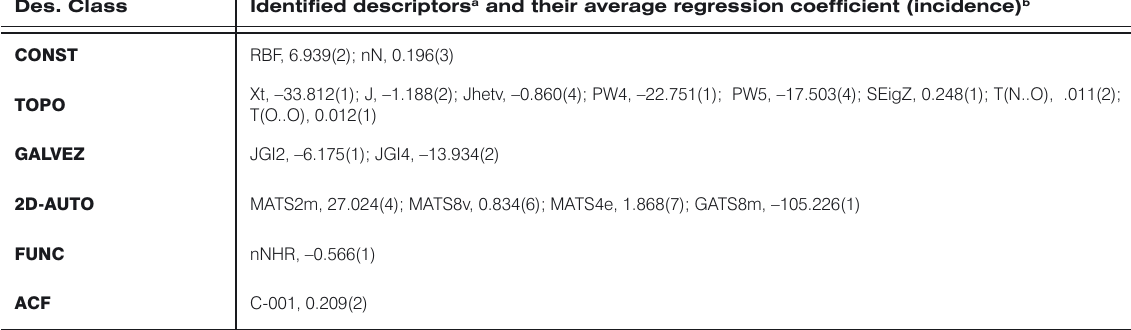
Table 6. Descriptor classes and identified descriptors in modeling the inhibition activities of human carbonic anhydrase, hpCA. Des.